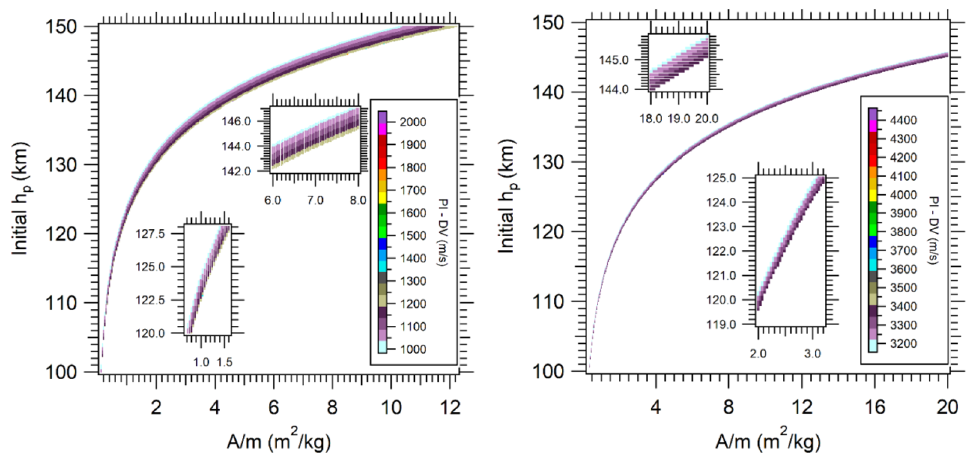
Figure 6. PI maps for aerocapture, V P = 0.246 VU (left), 0.336 VU